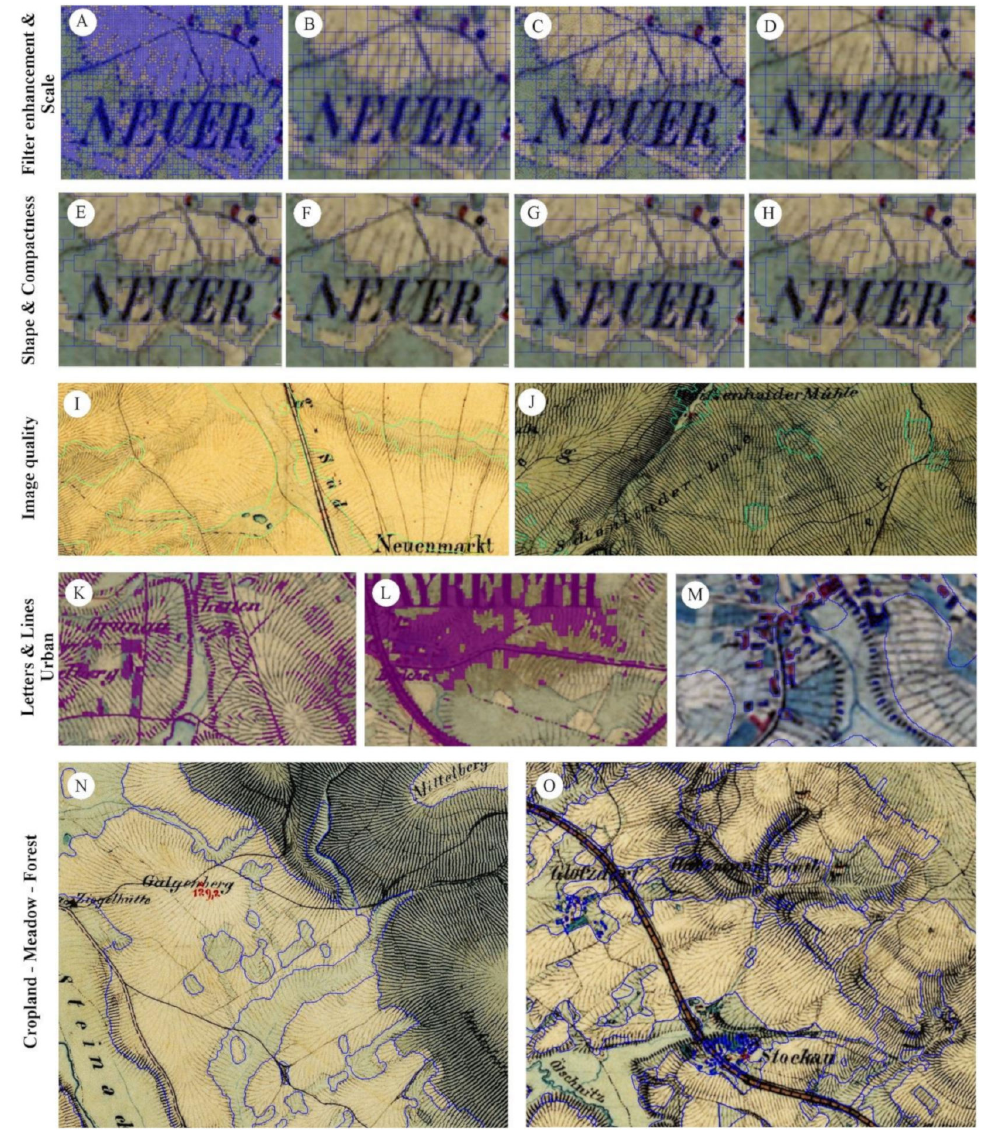
Figure 2. Classification results: ( A ) quadtree segmentation, Scale: 60, no filter; ( B ) quadtree segmentation, Scale 60, Frost Filter; ( C ) quadtree segmentation, Scale 100, no filter; ( D ) quadtree segmentation, Scale 100, Frost Filter; ( E ) multi-resolution segmentation, Shape: 0.1, Compactness: 0.9, Scale: 10; ( F ) multi-resolution segmentation, Shape: 0.1, Compactness: 0.9, Scale: 20; ( G ) multi-resolution segmentation, Shape: 0.5, Compactness: 0.8, Scale: 10; ( H ) multi-resolution segmentation, Shape: 0.5, Compactness: 0.8, Scale: 20; ( I ) image with faded colors or bleached where Meadow intersects cropland fields and the lines identify the final classification objects; ( J ) image with low contrast among classes where there are blue shades of rivers intersecting the forest, which are di ffi cult to distinguish; ( K ) letters & lines and urban are colored purple and intersect cropland and meadow objects; ( L ) dark objects such as stains are misclassified as letters & lines on the basis of their layer values; ( M ) urban objects (little red and black squares) usually overlap letters & lines, hampering discrimination; ( N ) subset of image (PB078) classified: meadow, cropland and forest are visible (Overall Accuracy: 0.81, Overall Kappa: 0.71); and ( O ) subset of image (PB158) classified: meadow, cropland, urban and forest are visible (Overall Accuracy: 0.98, Overall Kappa: